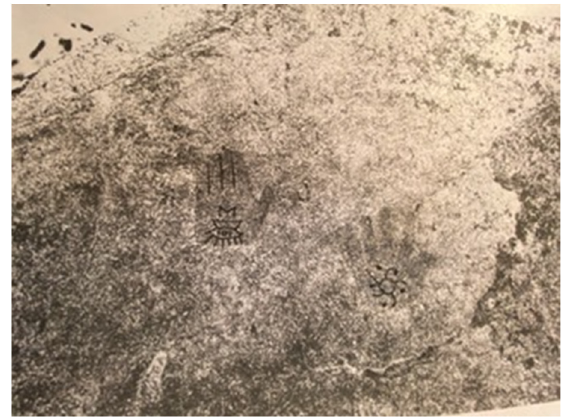
Figure 34. Digital photo enhancement using PhotoShop ® . Drawing on the resulting image illustrates an approximation of the faded handprints.